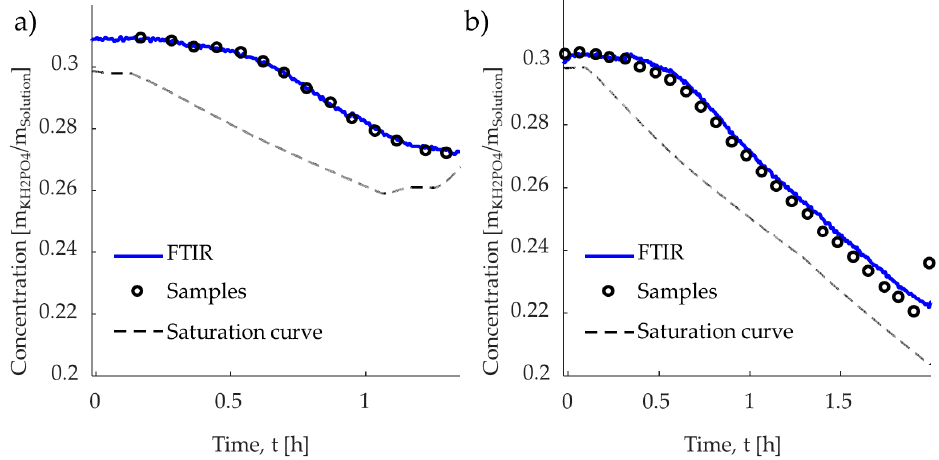
Figure A5. Concentration profile of ( a ) Exp. 1—KH 2 PO 4 and ( b ) Exp. 2—KH 2 PO 4 ; FTIR, offline samples and saturation Equation. (1).